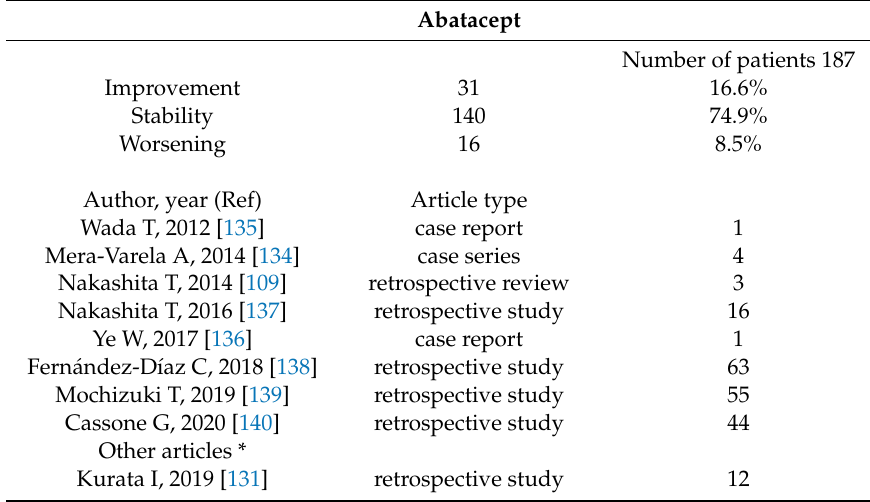
Table 5. Pulmonary e ff ects of abatacept in RA-ILD patients: a review of the literature.